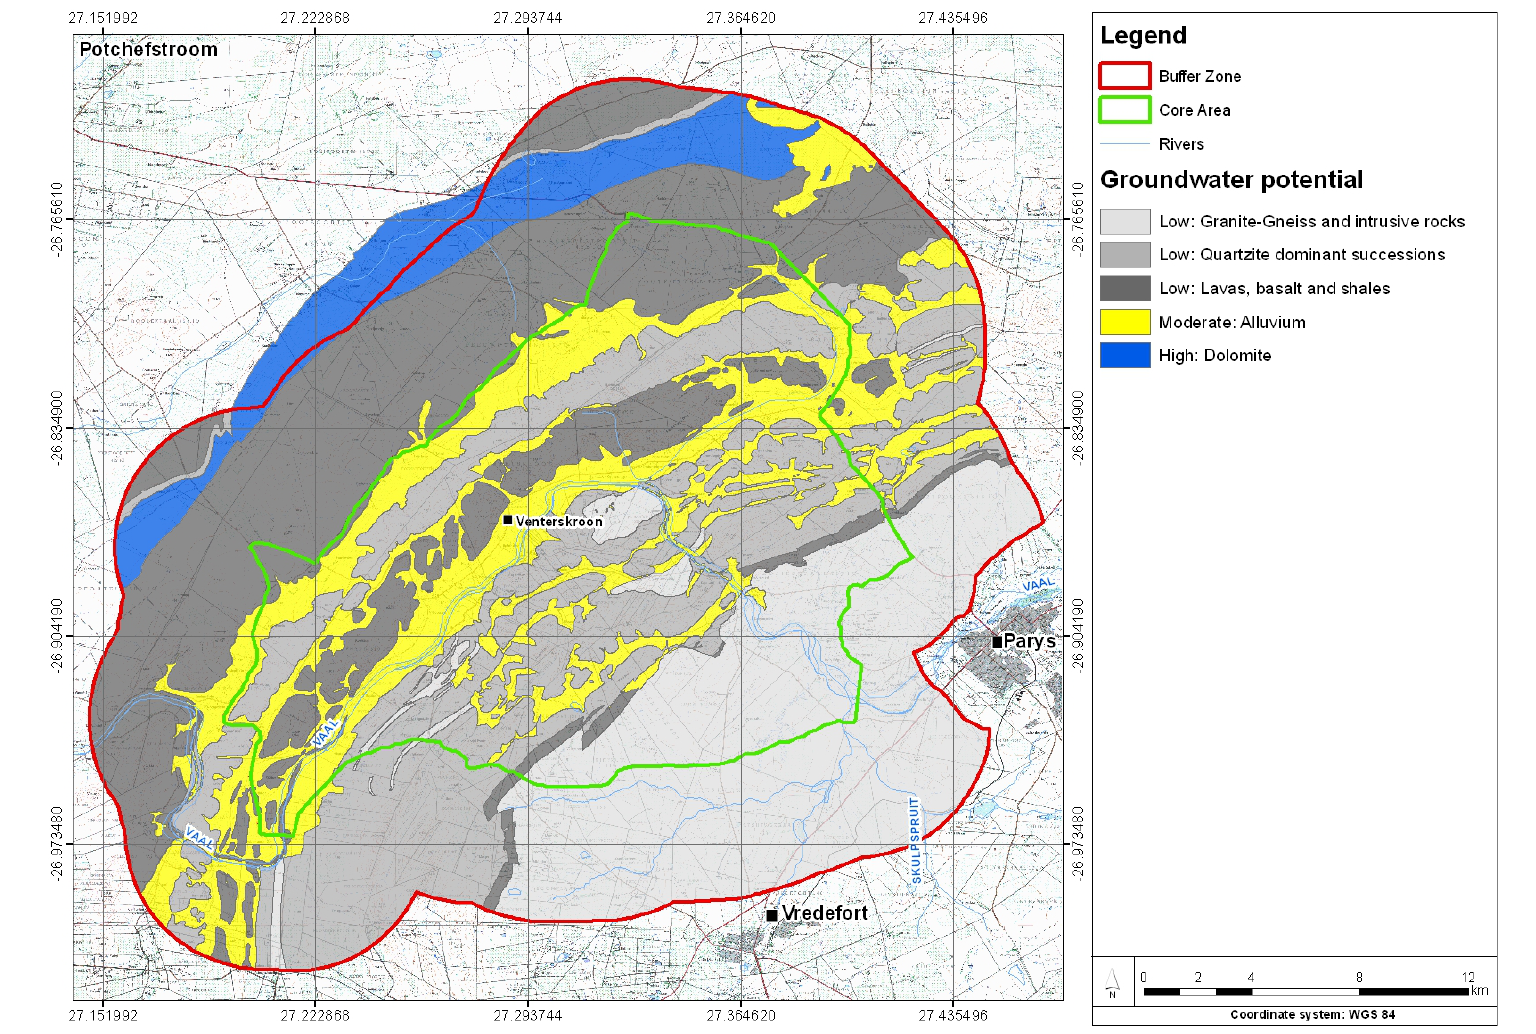
Figure 5 . Groundwater potential zones in the